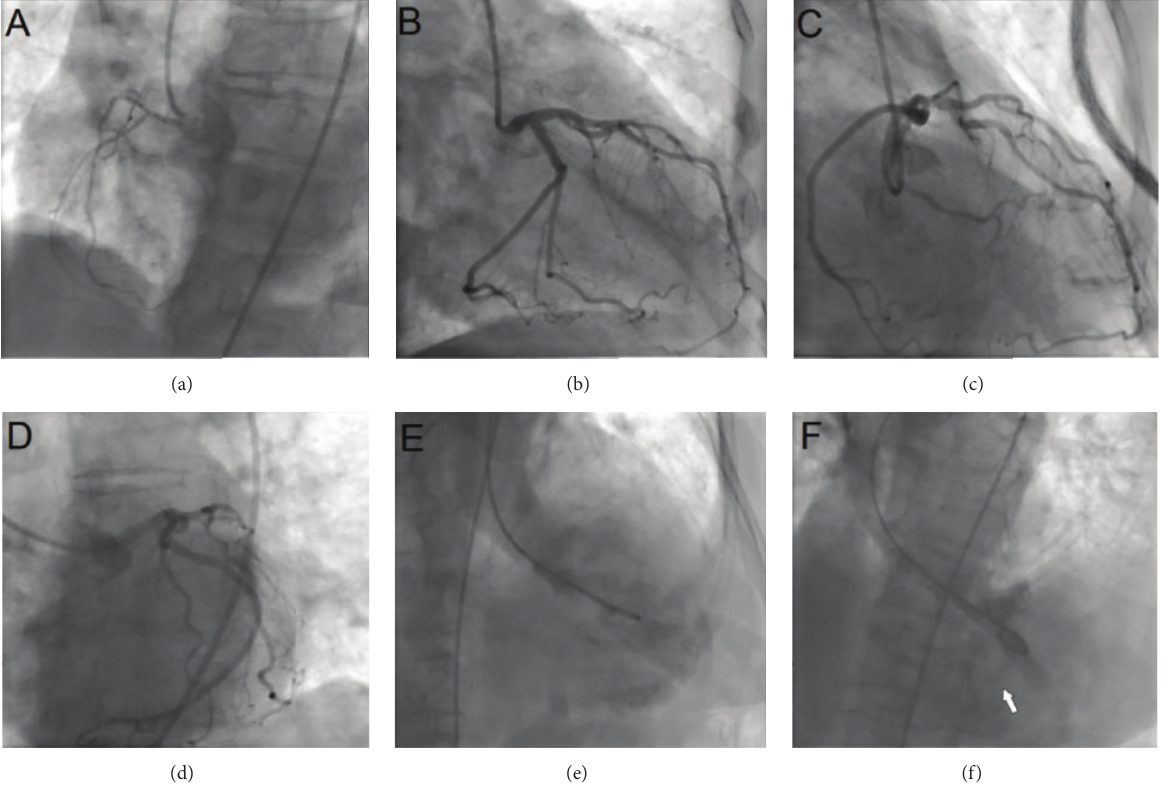
Figure 4: Coronary angiography describing coronary tree and biventricular function. (a) Small right coronary artery with an intermediate lesion in an acute marginal branch. ((b), (c), and (d)) Left circumflex and anterior descending coronary artery without significant lesions. ((e) and (f)) Left ventricular angiogram with the anterior and apical hypokinesia and the filling of right ventricle through the VSP